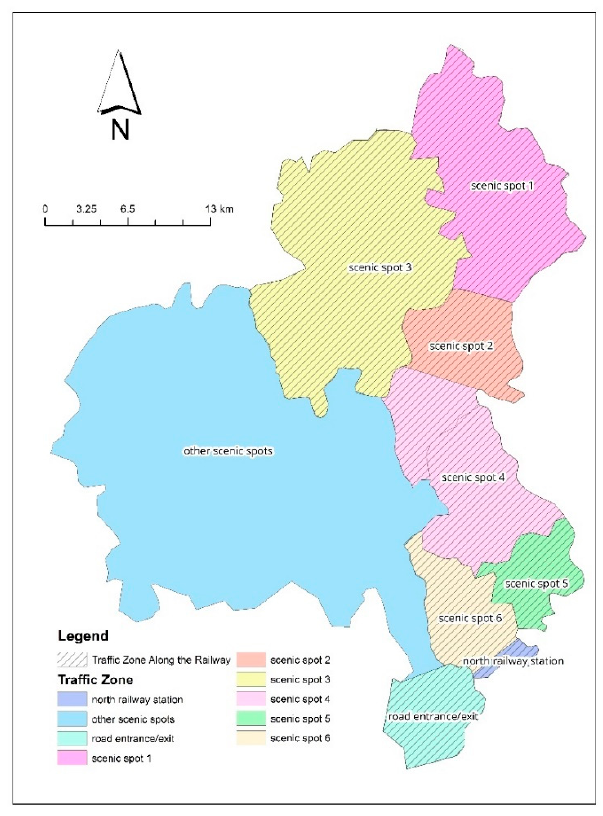
Figure 5. Spatial distribution of traffic zones.